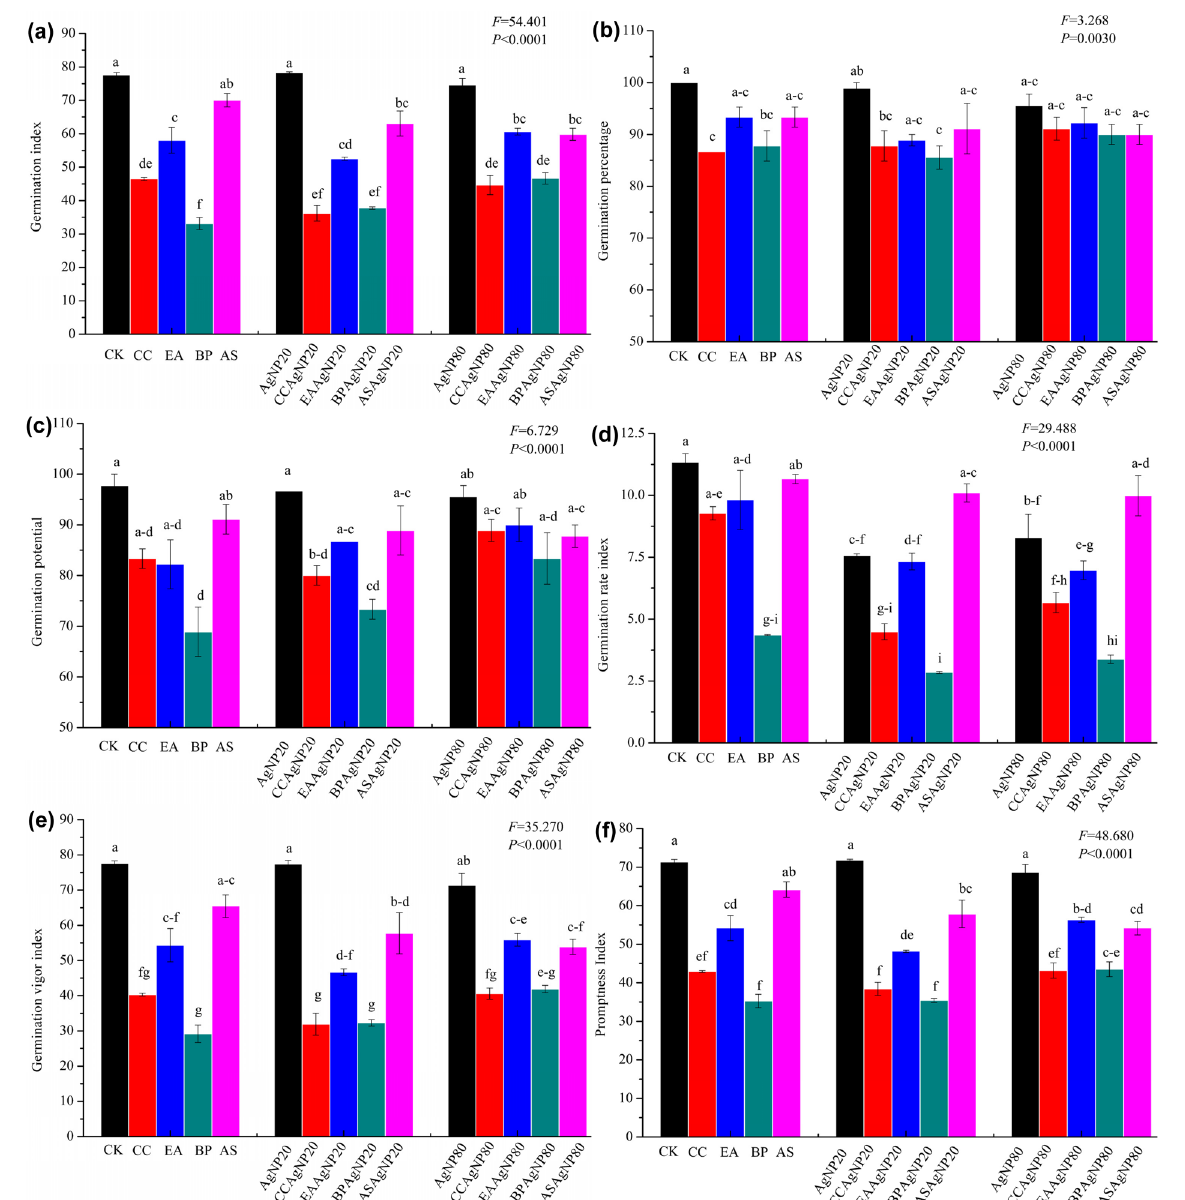
Figure 1. Seed germination indices of lettuce. Bars (means ± SE) with different letters mean statistically significant differences ( P < 0.05). The lowercase letters on top of the bars are presented as “a-c”, “a-d”, “b-d”, “g-i”, “d-f”, “f-h”, “e-g”, and “c-e” means “abc”, “abcd”, “bcd”, “ghi”, “def”, “fgh”, “efg”, and “cde”,